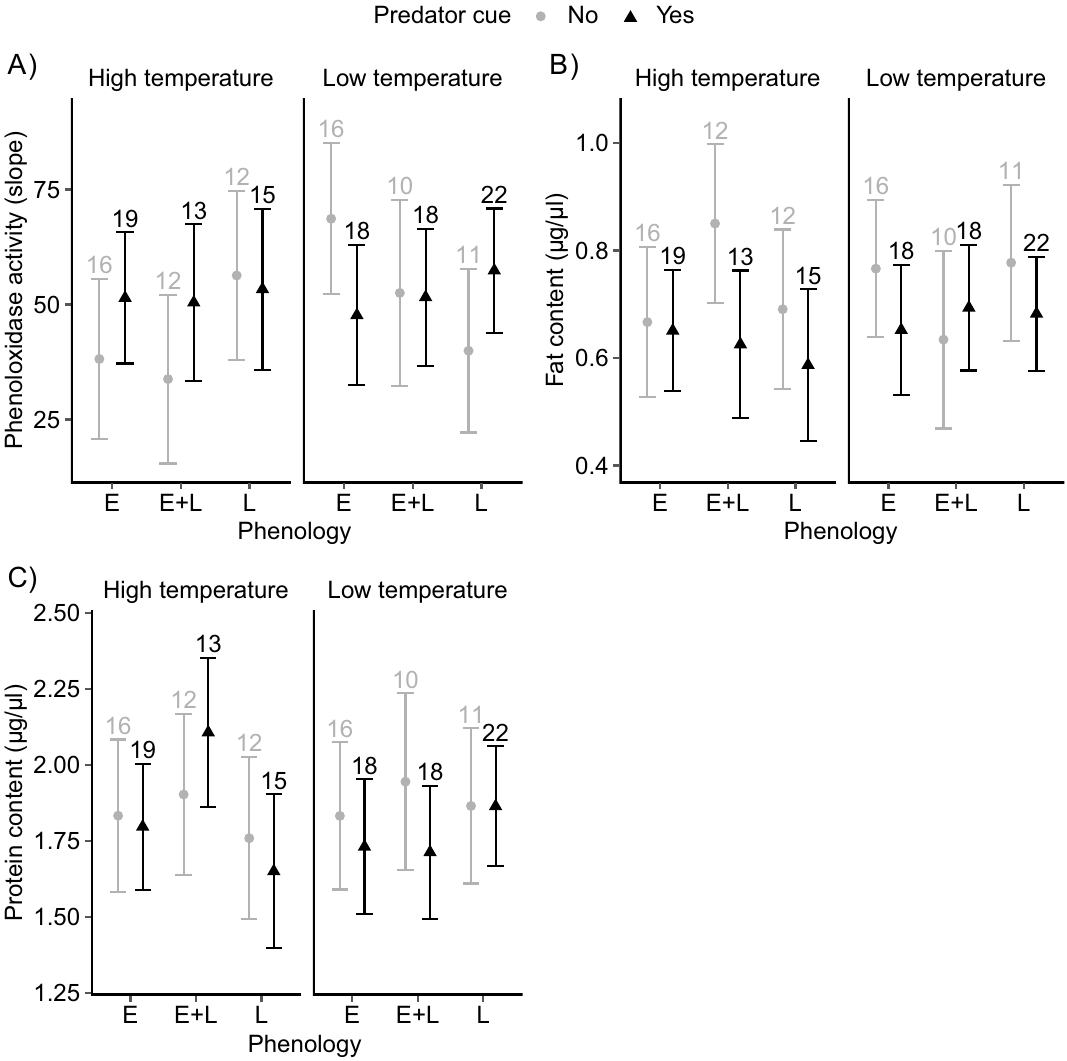
Figure 3. ( A ) Phenoloxidase activity, ( B ) fat content and ( C ) protein content, across different phenology groups (E, E + L and L), temperatures (high and low) and predator cues (no and yes). Error bars indicate estimated 95% CI. The numbers on top of error bars represent the number of larvae within each group. Letter codes were not added due to lack of support of statistically significant differences between groups from post-hoc tests. Abbreviations as in Fig.